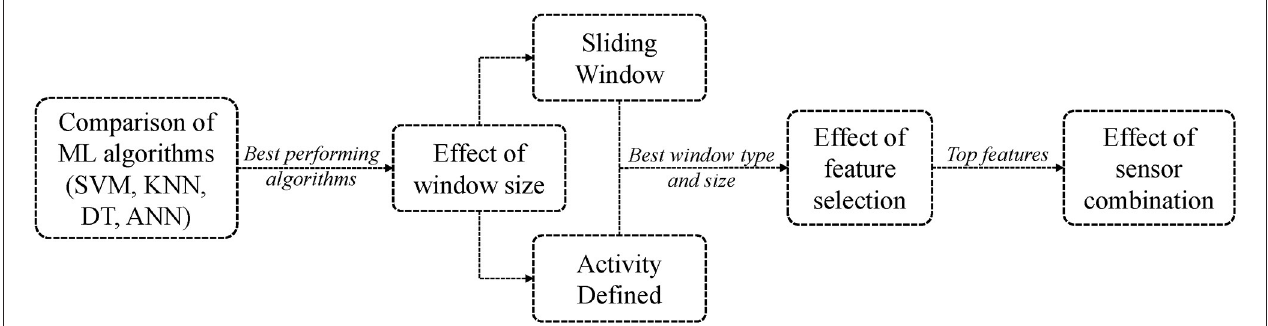
FIGURE 7 | Overall process to develop recommendations for state identification.